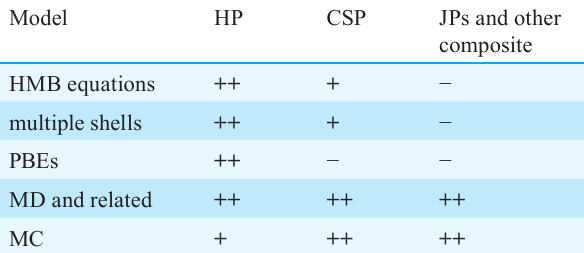
Table 1 Usefulness of most popular numerical models for modeling the synthesis of particles with a specific